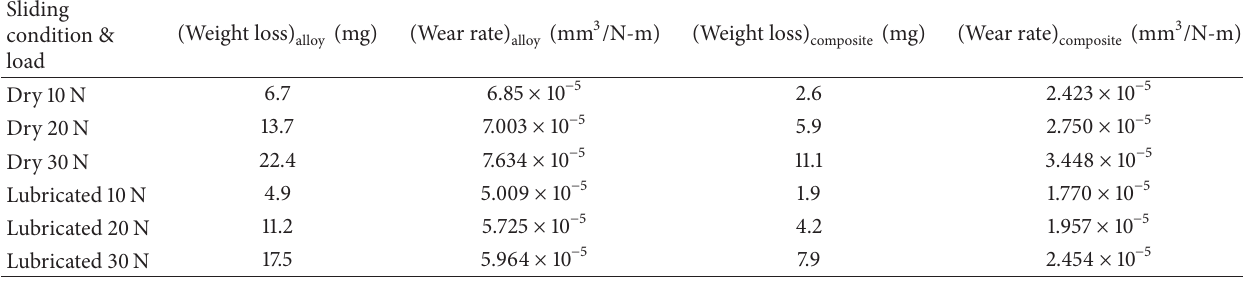
Table 6: Variation of weight loss and wear rate for aluminum matrix alloy and silicon carbide based aluminum metal matrix composite when sliding speeds = 3.77 m/s.